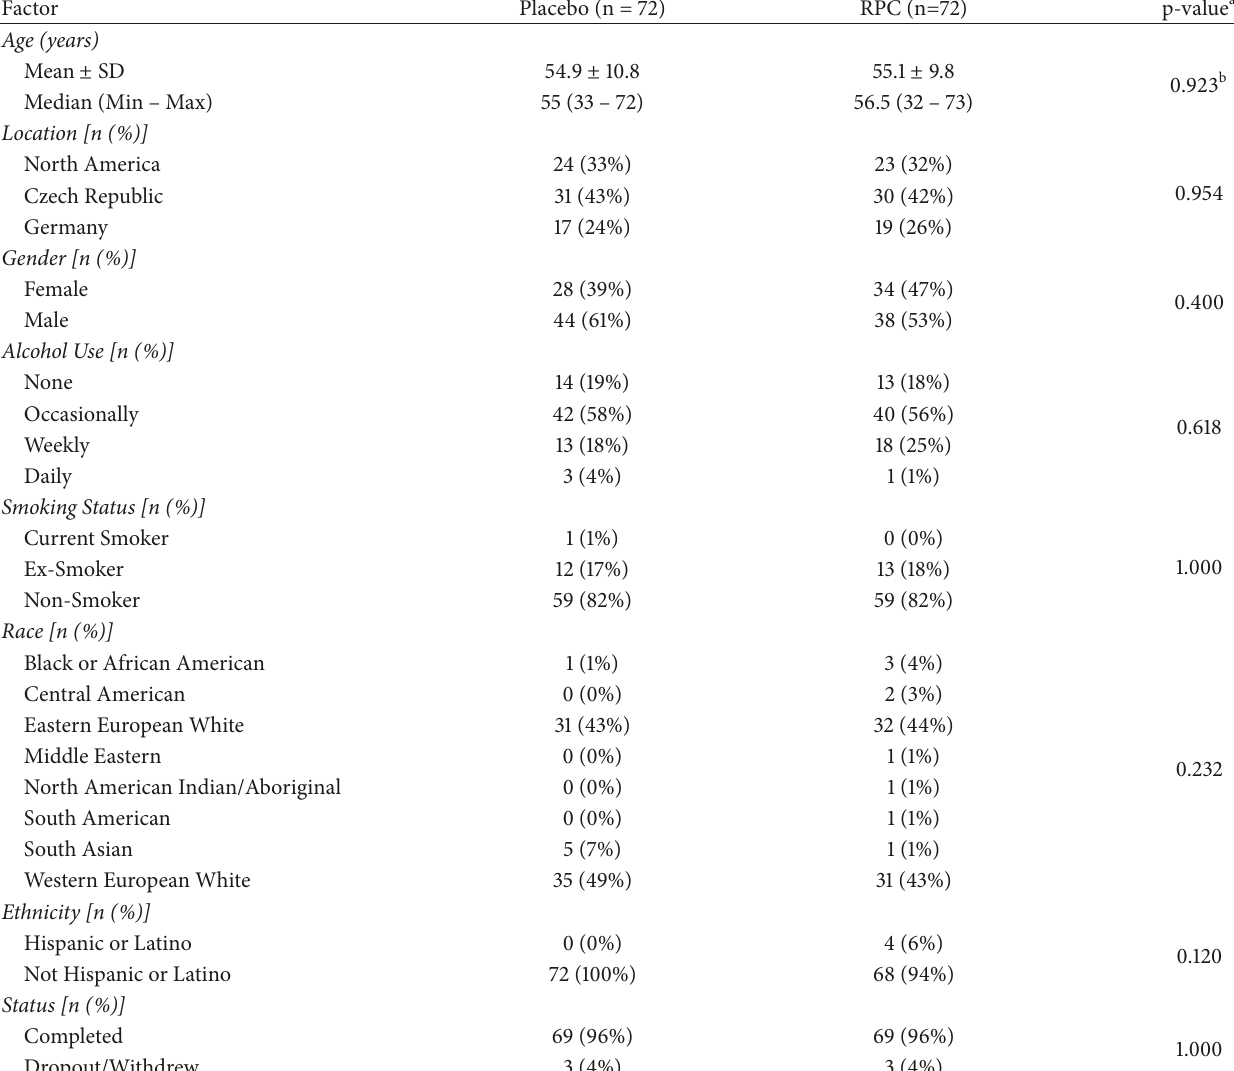
Table 1: Demographic and lifestyle characteristics of the placebo and RPC groups in the ITT population